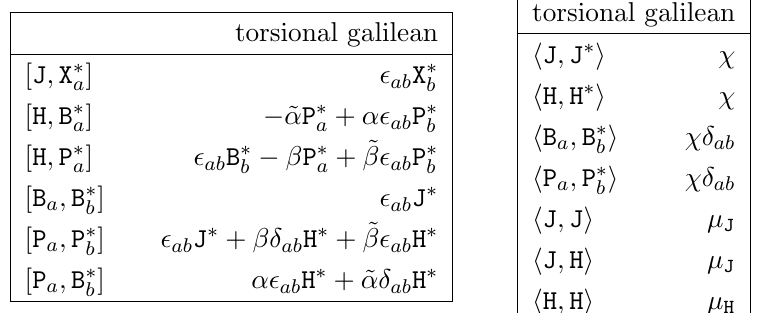
Table 3 . Coadjoint extension of the torsional galilean algebras. X (cid:3) is nondegenerate for (cid:31) 6 =